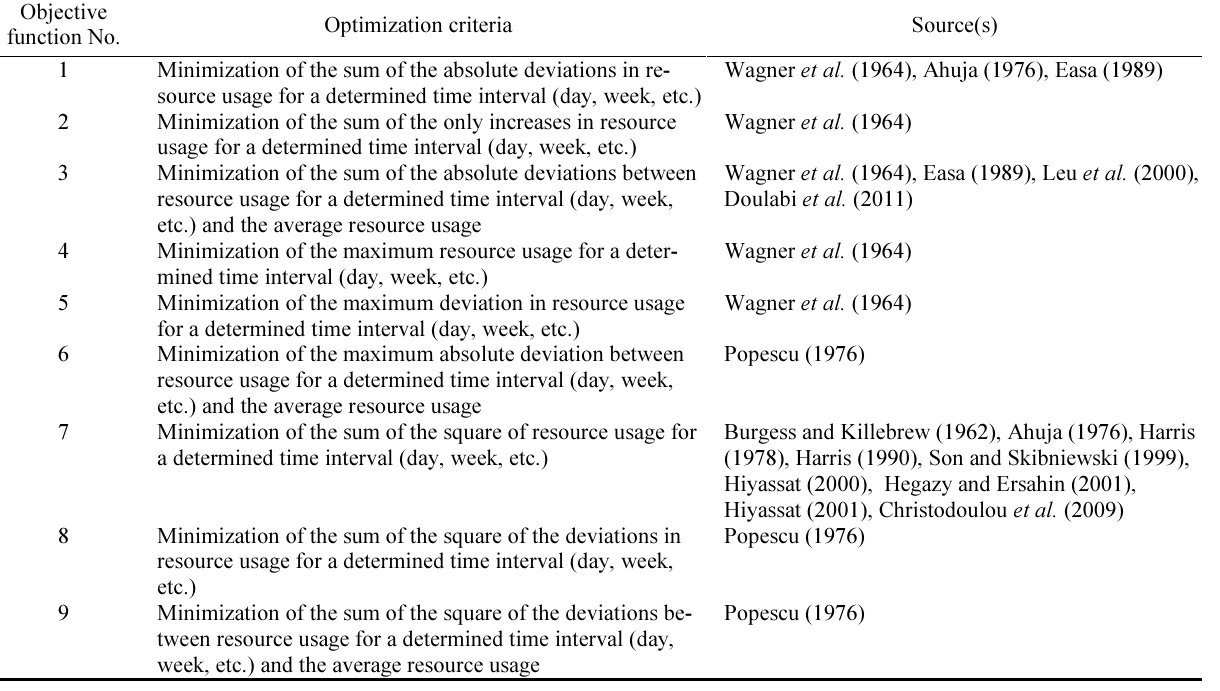
Table 1. Objective functions for resource leveling